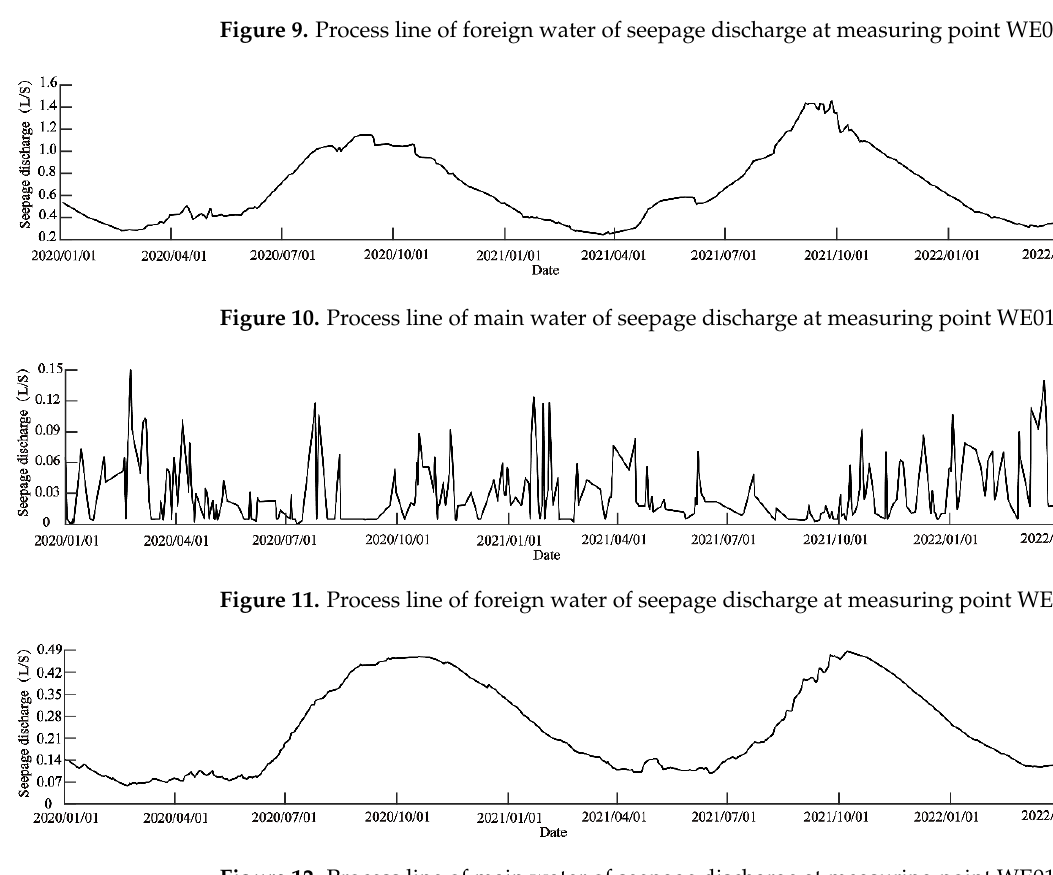
Figure 13. Process line of foreign water of seepage discharge at measuring point WE01ZXD. From the separated seepage discharge, it can be found that the reservoir water level and seepage discharge show a positive correlation and a certain time lag. The process line of the main water seepage discharge not only keeps consistent with the change of the